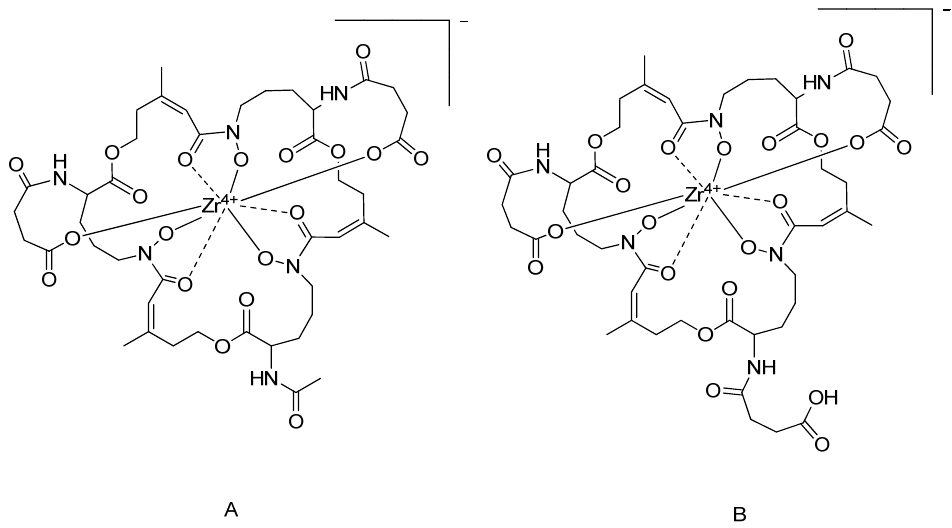
Figure 2. Postulated coordination structures of Zr-FSC(succ) 2 AA ( A ) and Zr-FSC(succ) 3 ( B ).